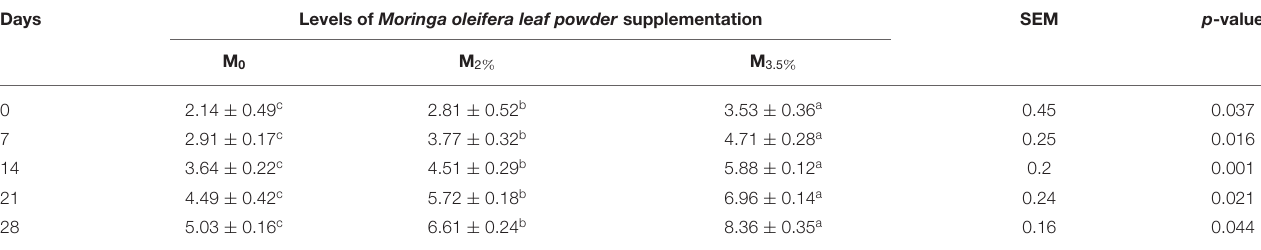
TABLE 11 | Effect of feeding Moringa oleifera leaf powder supplemented goat milk on body weight (kg) of their kids. Days Levels of Moringa oleifera leaf powder supplementation SEM M